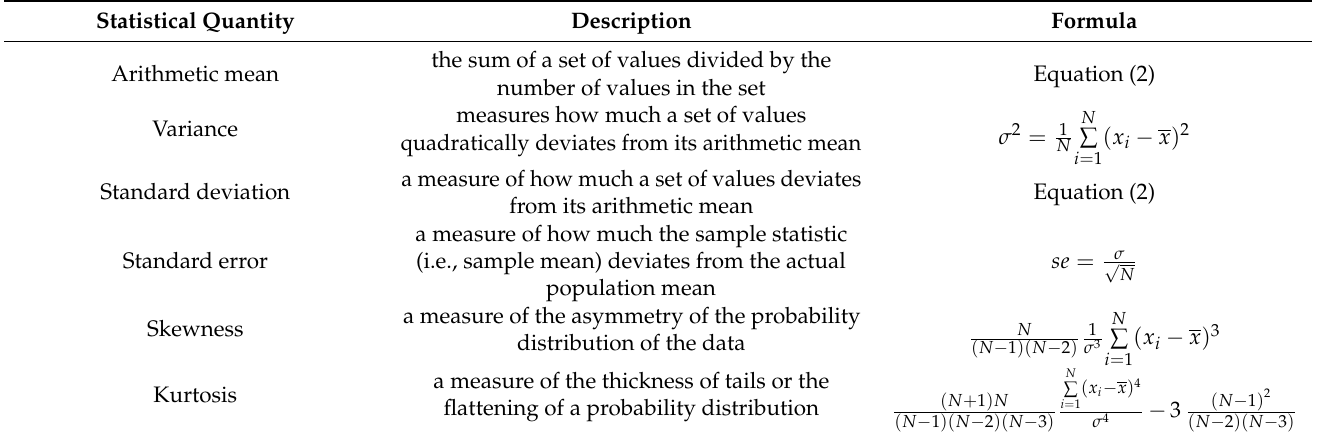
Table 3. Summary of all used statistical